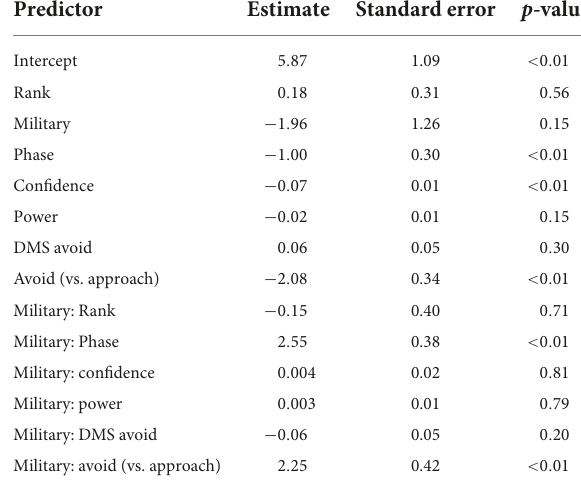
TABLE 3 Predictive model for decision-making time.